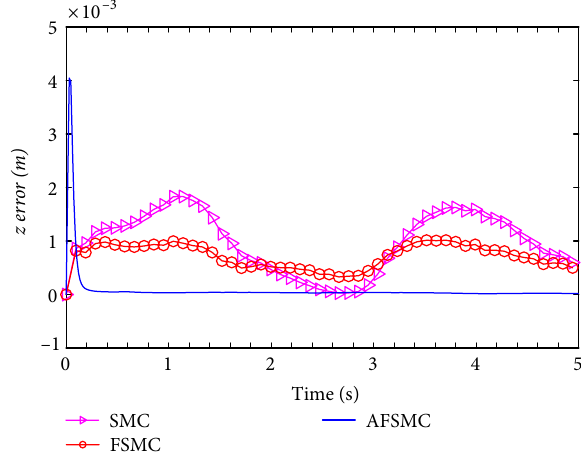
. 2 Figure 17: The tracking error with desired trajectory in z direction.